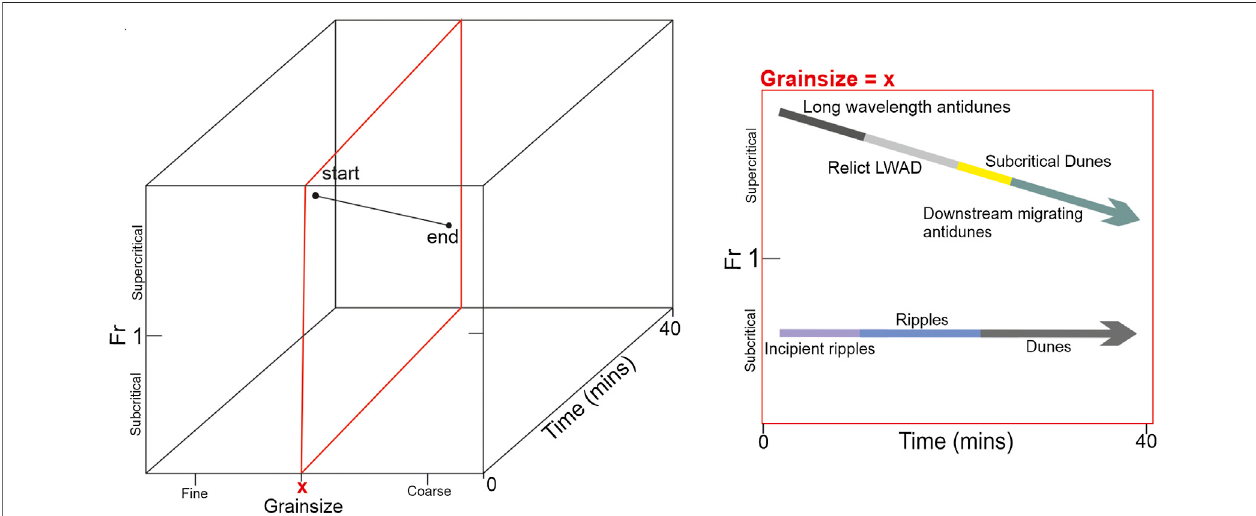
FIGURE12| Conceptualphasediagramwithathirdaxisfortime,depictinghowabedundersteadyconditionsmightevolve(basedonExperiment5),comparedto bedforms under a waning current (based on Experiment 2).